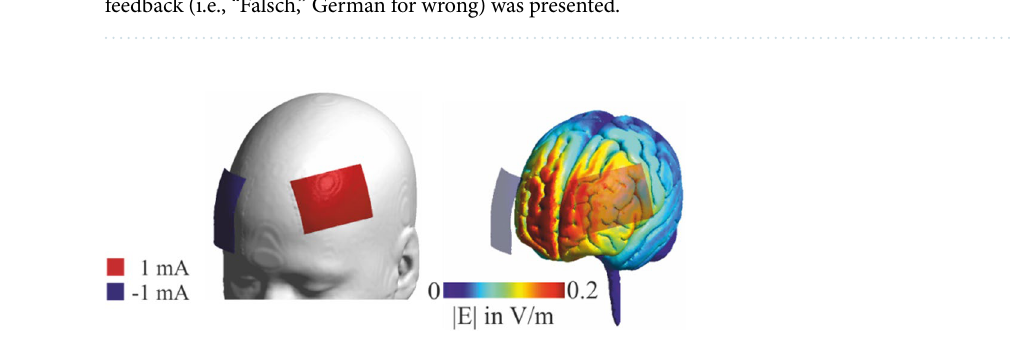
Figure 2. Demonstration of the electrode placement and simulation of electric field distribution of applied stimulation parameters on MNI head/brain with SimNibs (simnibs.org, Version 3) 40–42 . The stimulation electrode (red) was placed over F3, corresponding to the left dlPFC. The reference electrode (blue) was placed over Fp2, corresponding to the right supraorbital